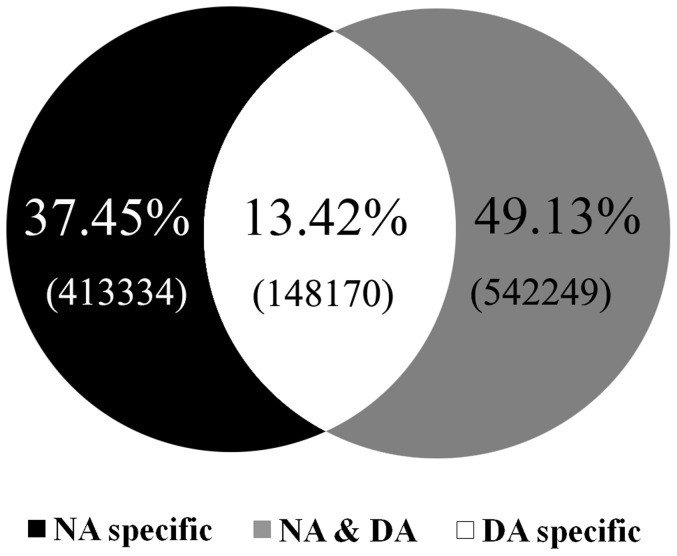
Common and specific sequences summary of unique sRNAs between non-aestivation (NA) and DA (deep-aestivation) states.Three groups are shown: those specific to NA, those specific to DA, and those that are common to both. The percentage distribution of sequences between these three groups is shown along with the number of sRNA sequences in brackets.